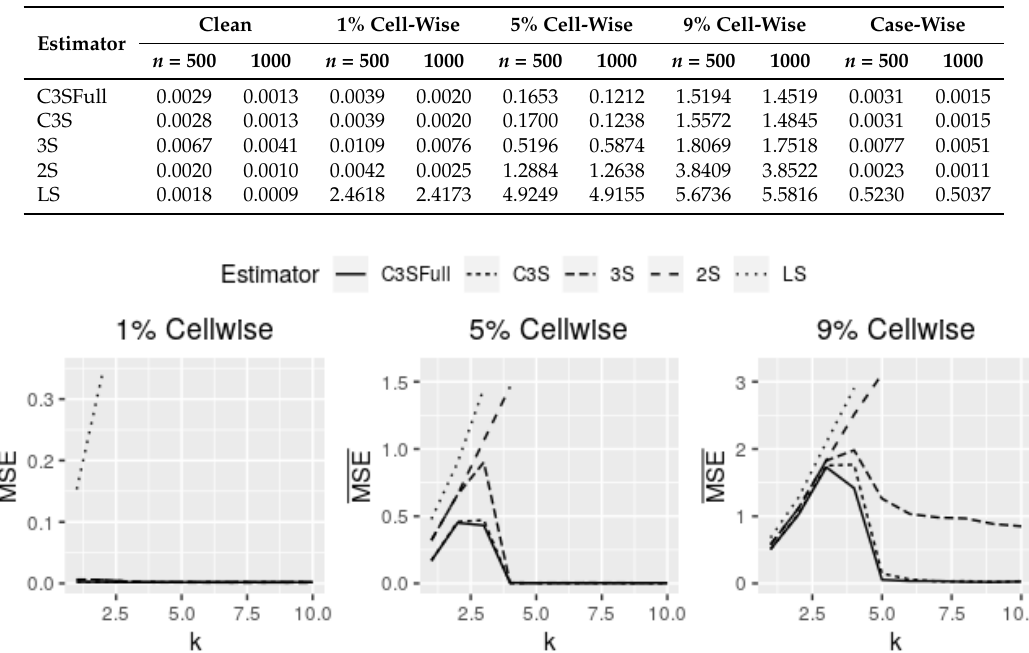
Figure 2. MSE for indicated cell-wise contamination values k in models with p = 15 continuous covariates and n = 1000. Source: the authors.